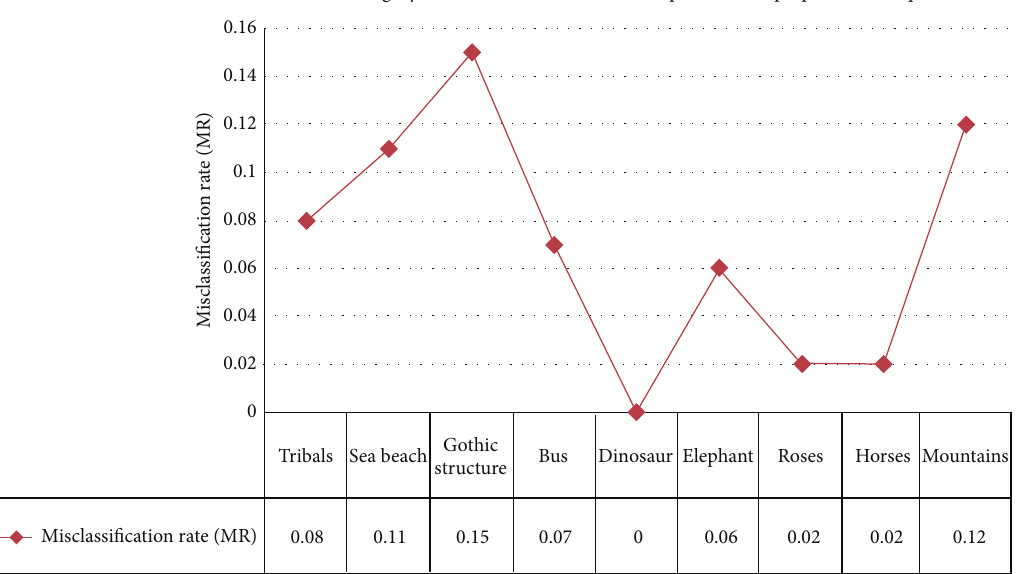
Figure 8: Comparison of misclassification rate (MR) for different categories.